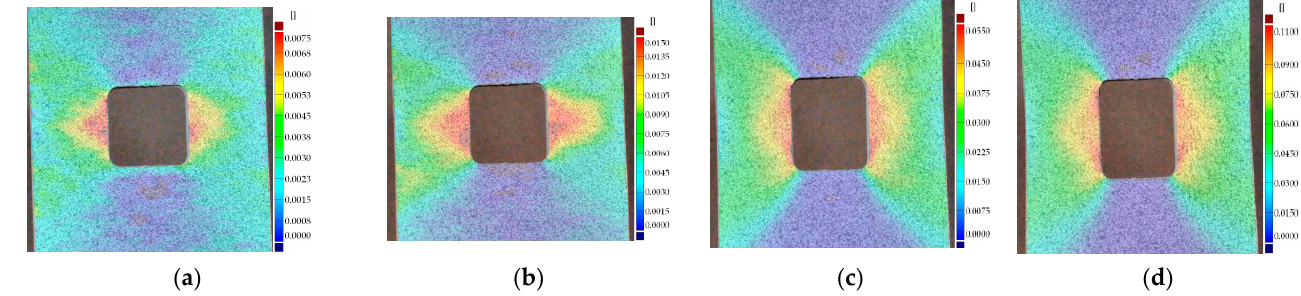
Figure 11. Distribution of strains on the surface for sample no. 3 with rectangular holes with a fillet radius R2 for strain: ( a ) ε TOT = 0.3%; ( b ) ε TOT = 0.37%; ( c ) ε TOT = 0.85%; ( d ) ε TOT = 1.48%.